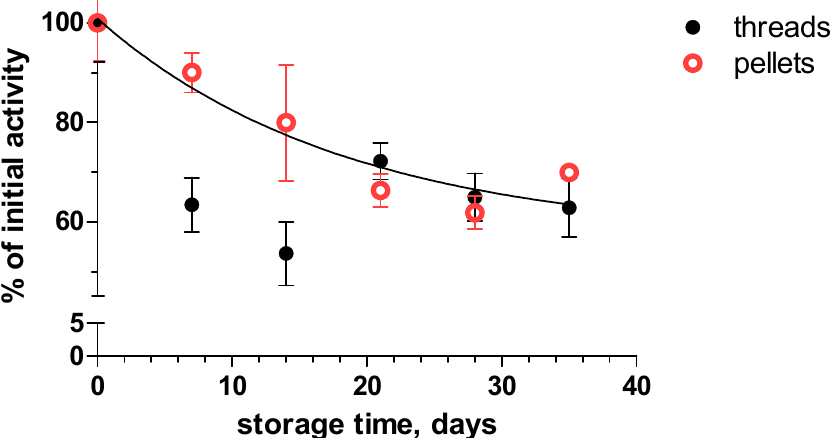
Figure 4. The storage stability of immobilized pectinase in 0.2 M sodium acetate buffer (pH 4.8) at 4 °C.